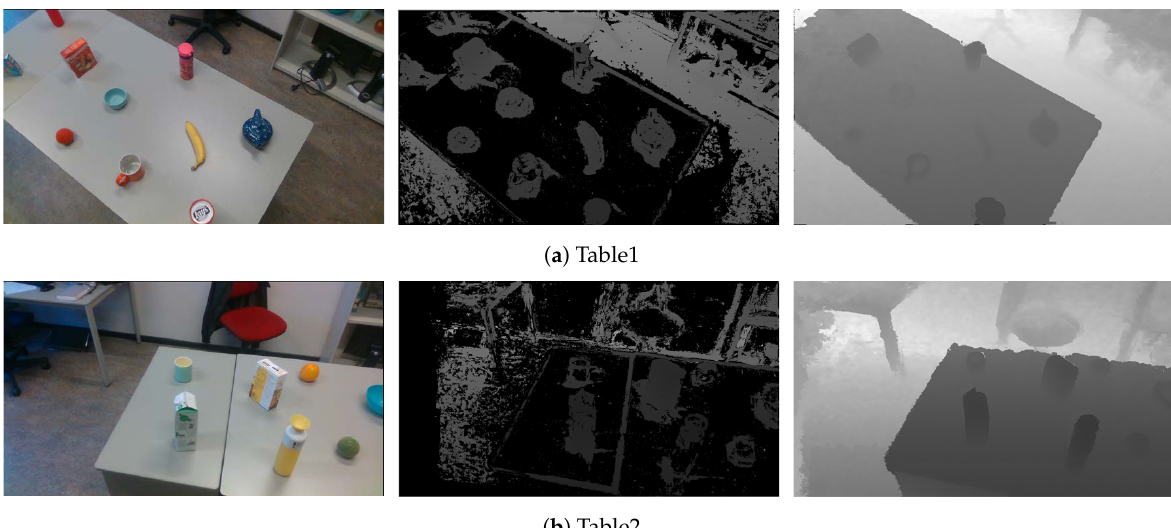
Figure 11. The depth fusion results on table1 and table2 scenarios. The first column are color images, and the second column are the estimated depth images by COLMAP and the third column are the depth images generated by our